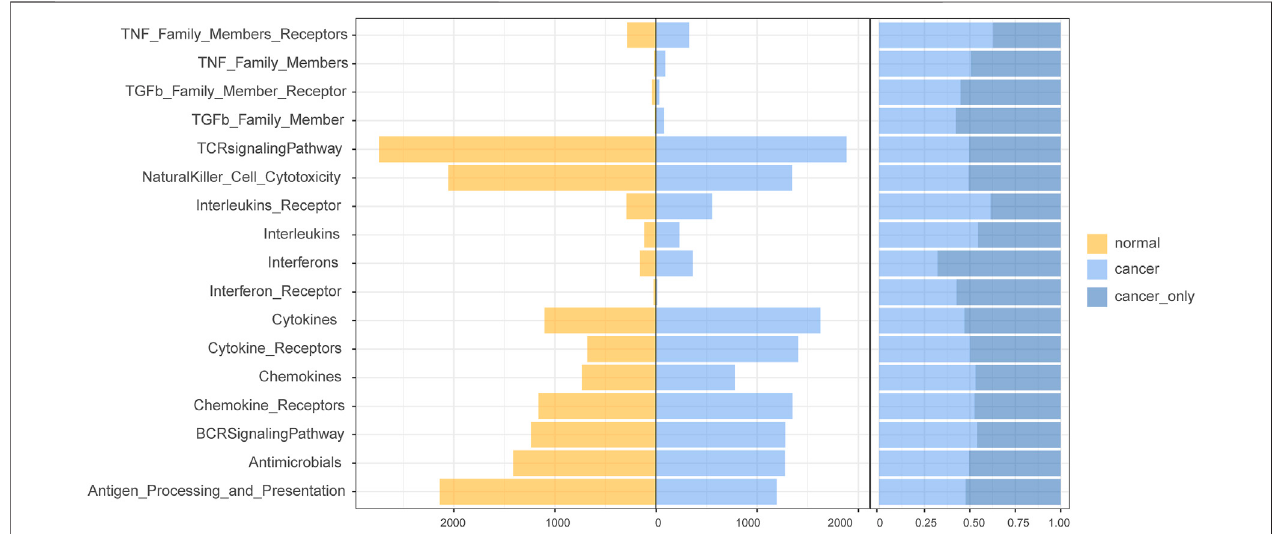
FIGURE 3 | The number of immunofunctional pathway-enriched lncRNA in hepatocellular carcinoma (HCC) and normal samples.